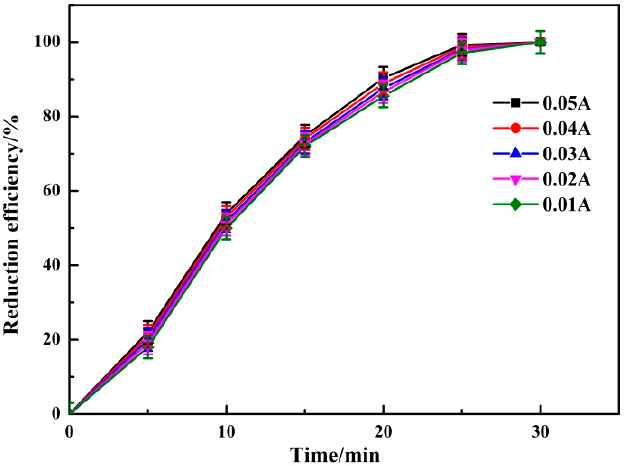
Figure 4. Effect of current intensity on reduction efficiency of chromium. (Volume of H 2 SO 4 = 0.50 mL, Figure 4 Effect of current intensity on reduction efficiency of chromium. initial concentration of Cr (VI) = 1.000 Figure 4 Effect of current intensity on reduction efficiency of chromium. ( Volume of H 2 SO 4 = 0.50 mL, initial concentration of Cr (VI) = 1.000 g/L). ( Volume of H 2 SO 4 = 0.50 mL, initial concentration of Cr (VI) = 1.000 g/L).